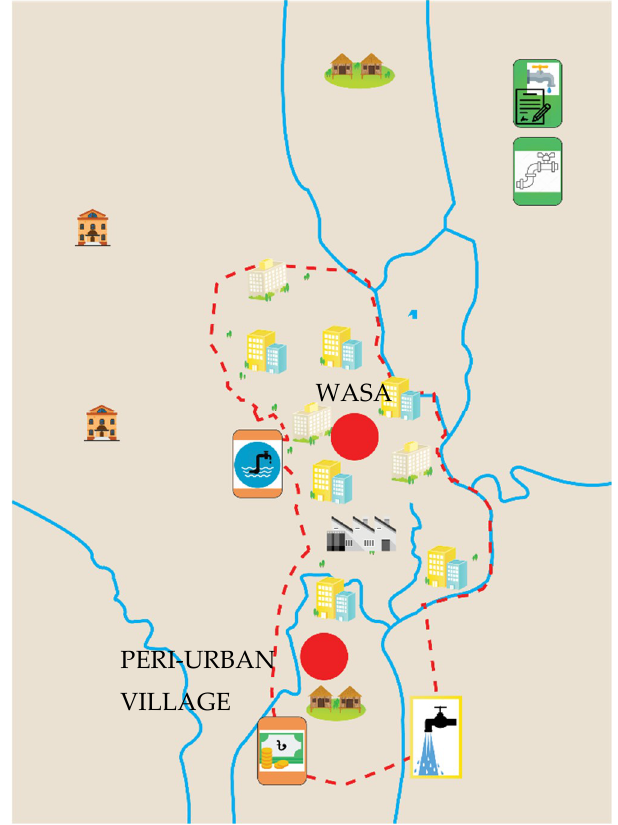
Figure 5. Game play in round 1 (Game 2).